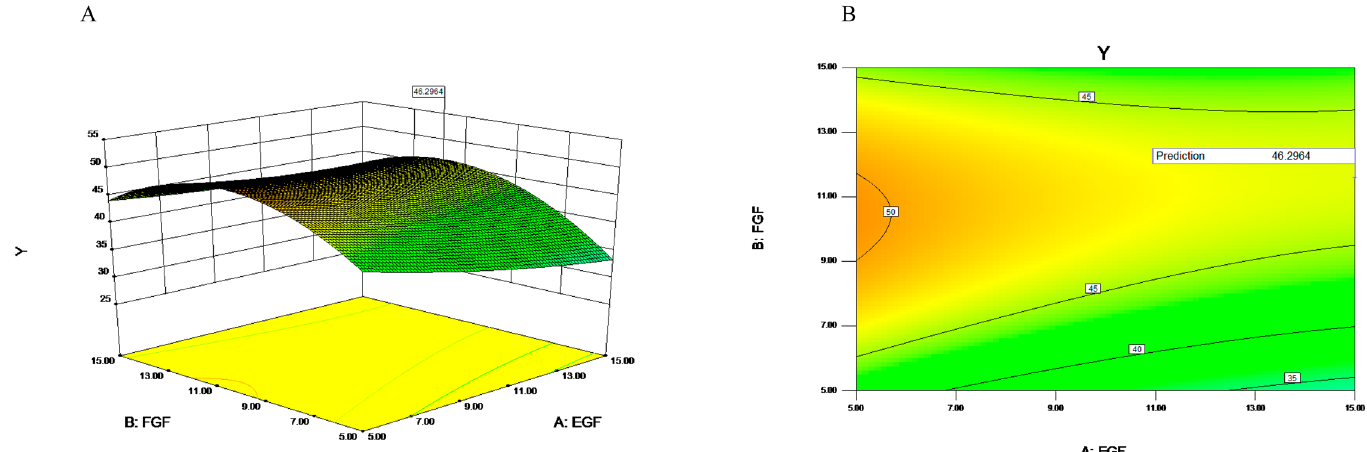
Fig 4. Response surfaceplot of the regression equation (EGF, FGF). The three-dimensionalresponsesurface plots (A) and contour charts (B) were used to illustrate the individualand interactive effects of EGF and FGF.